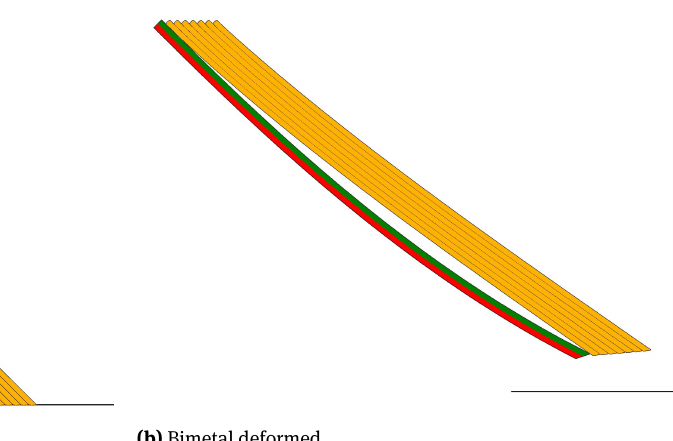
Figure 2: The idea of using bimetal in brush seal